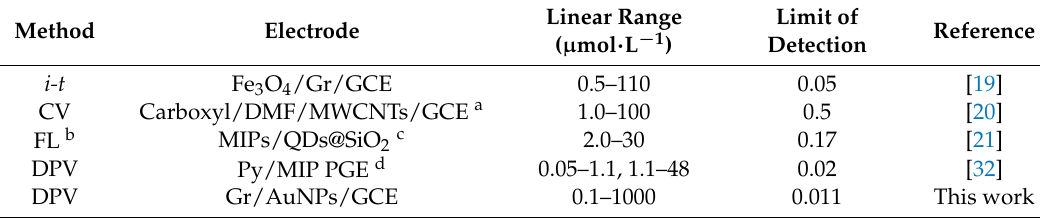
Table 1. Comparison of SAM determinations using the proposed and reference methods.